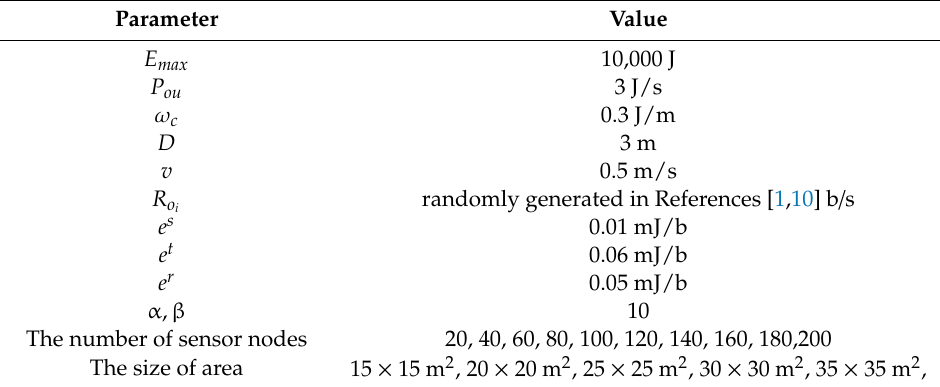
Table 4. Parameter Setting.